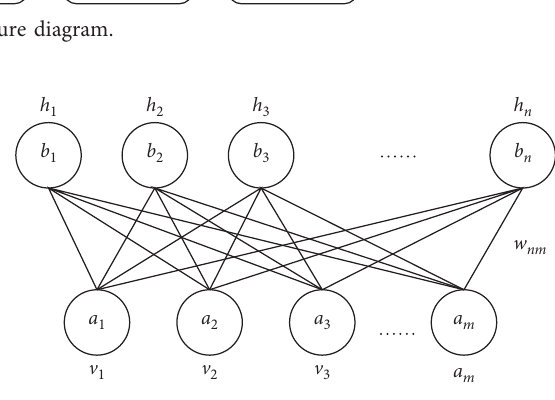
Figure 2: RBM structure